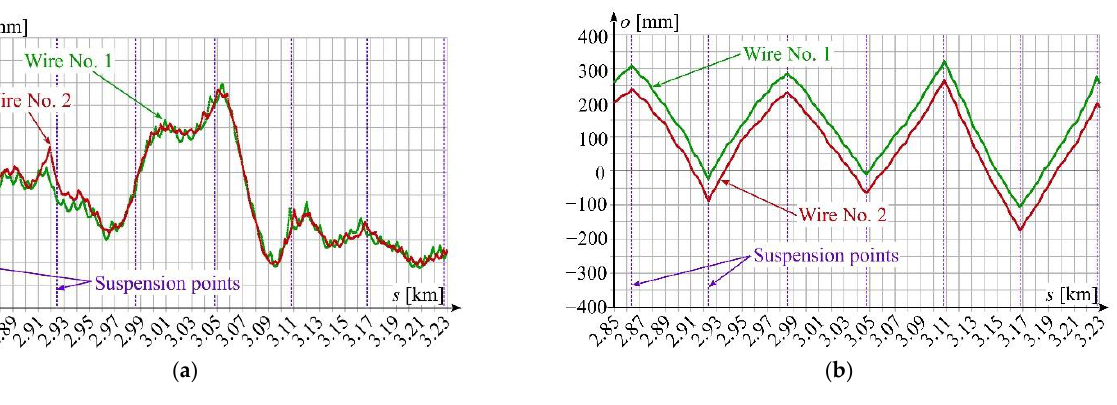
Figure 2. Overhead contact line DC 3 kV: ( a ) height h ( s ) of OCL suspension with two contact wires; ( b ) stagger o ( s ) of contact wires; source: own elaboration by the authors of this